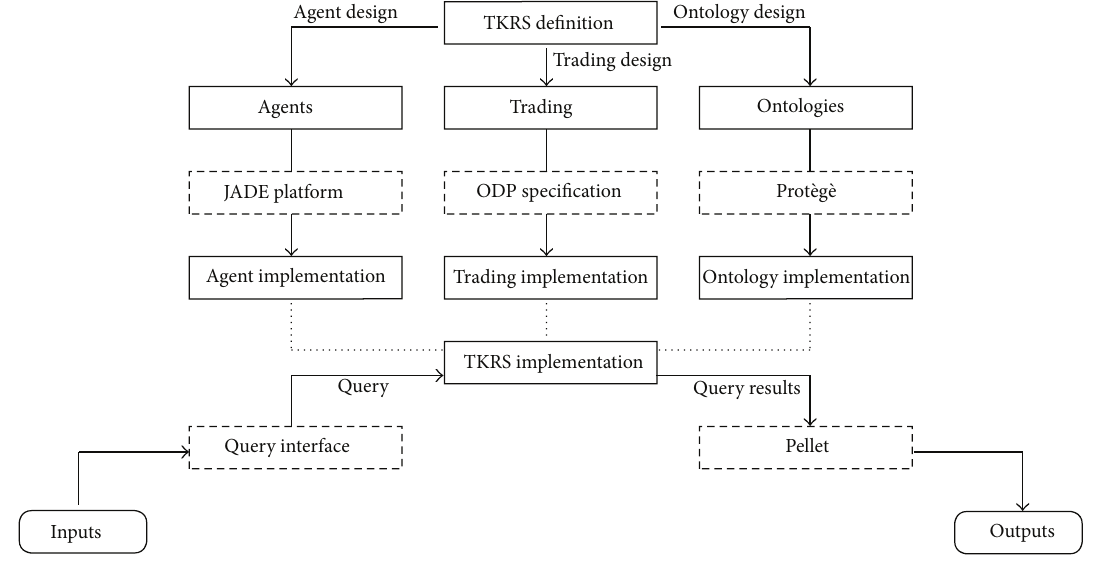
Figure 17: OntoTrader restrictions for TKRS